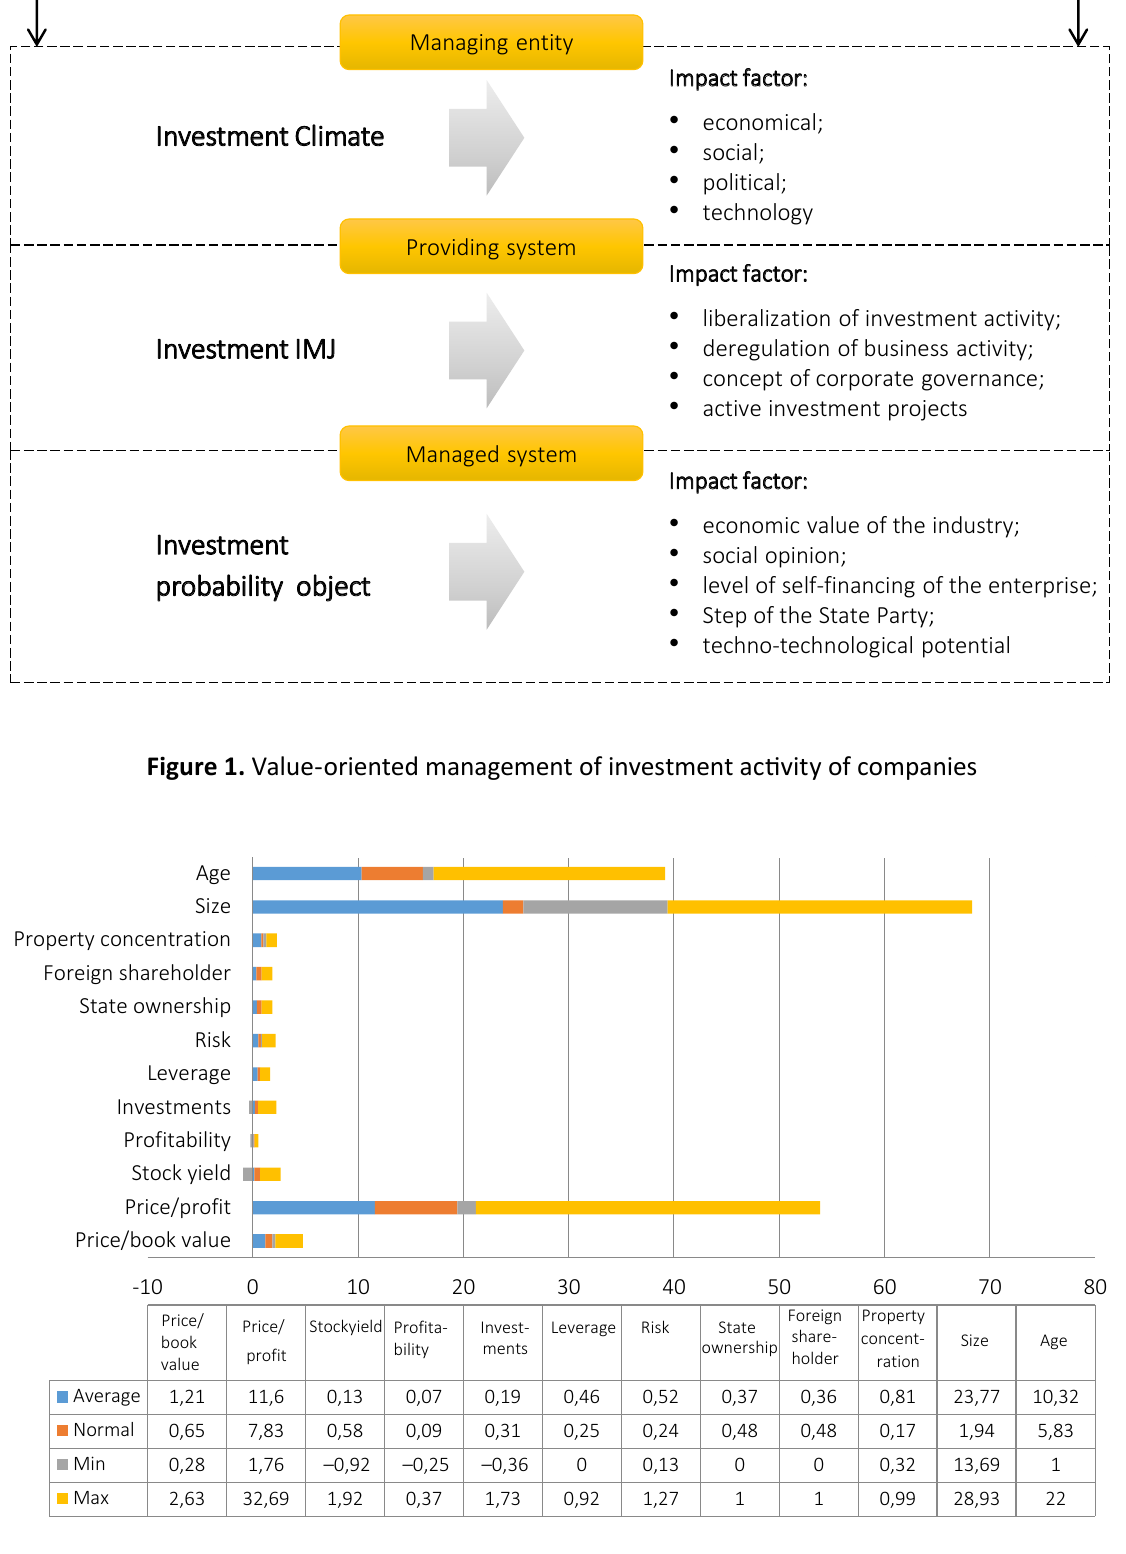
Figure 2. Descriptive statistics,